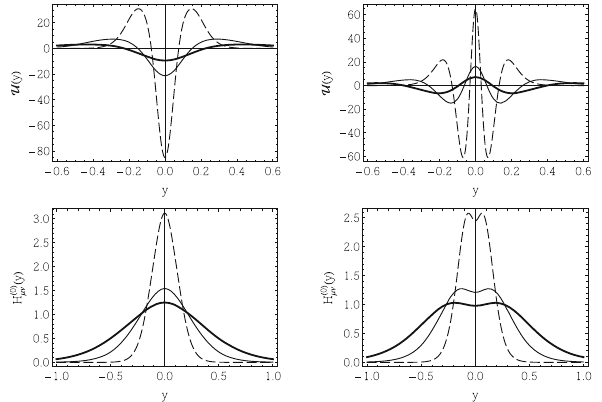
Fig. 23 Potential of stability (top panel) and zero mode (bottom panel) for the model studied in Sect. 3.3, represented for λ = 0 . 7 , 0 . 8 , 0 . 9 and ψ = ϕ = 10 (left panel), ψ 0 0